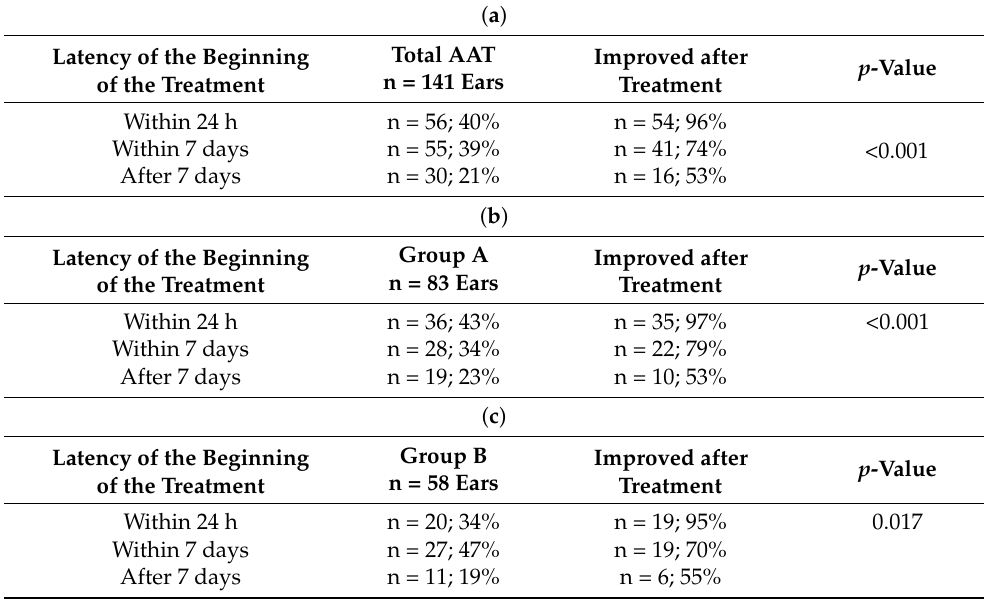
Table 2. ( a ) Latency of the beginning of the treatment—the whole set (total AAT). ( b ) Latency of the beginning of the treatment—Group A (soldiers). ( c ) Latency of the beginning of the treatment—Group B (civilian persons).